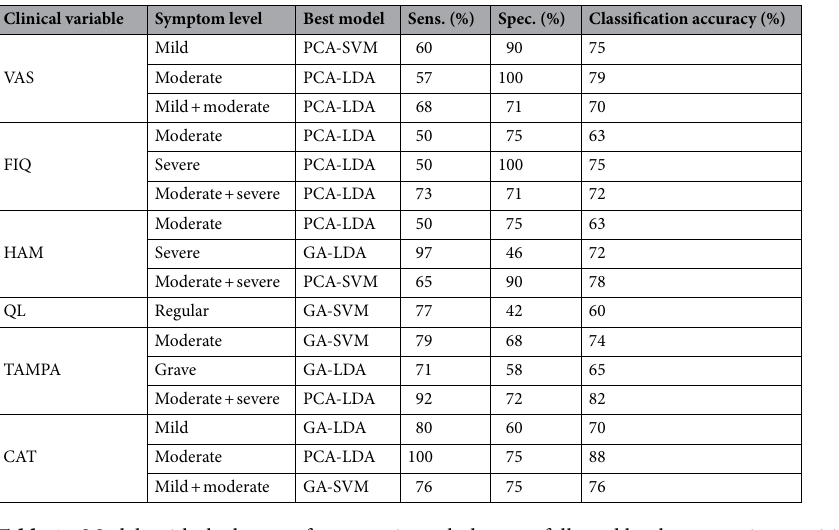
Table 1. Models with the best performance in each data set, followed by the respective sensitivity (Sens.), specificity (Spec.) and accuracy